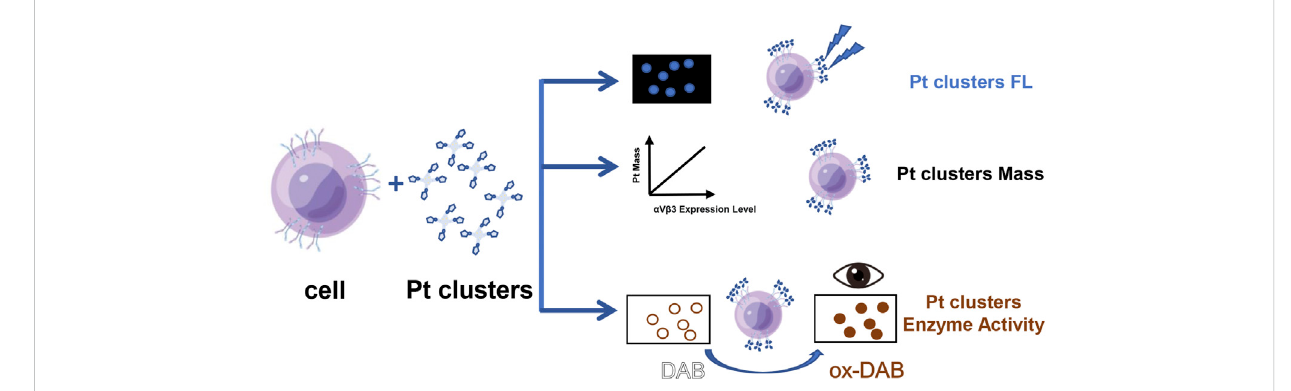
FIGURE 1 Schematic illustration of the method to detect integrin in cells via Pt clusters.